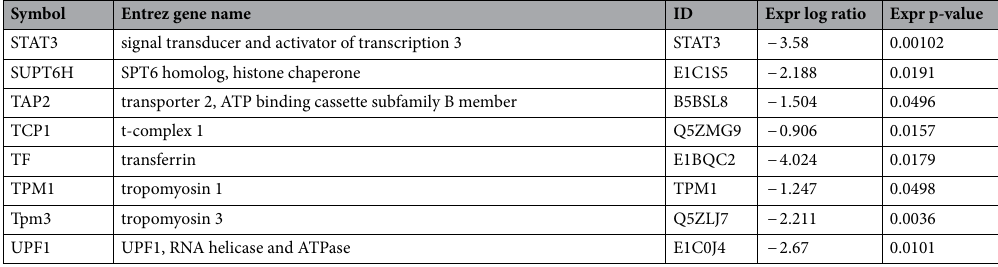
Table 3. Differentially expressed (down regulated) proteins in tibia of BCO compared to healthy chickens.